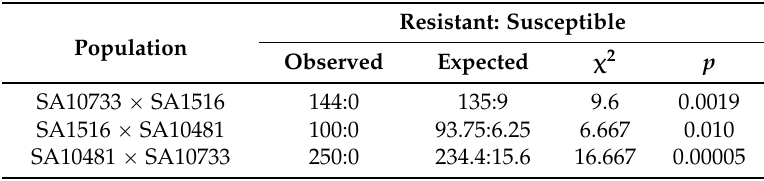
Table 3. Pairwise allelism test between resistant M. truncatula accessions. Chi-square analysis for two unlinked Mendelian dominant genes indicates the resistance genes are either allelic or tightly